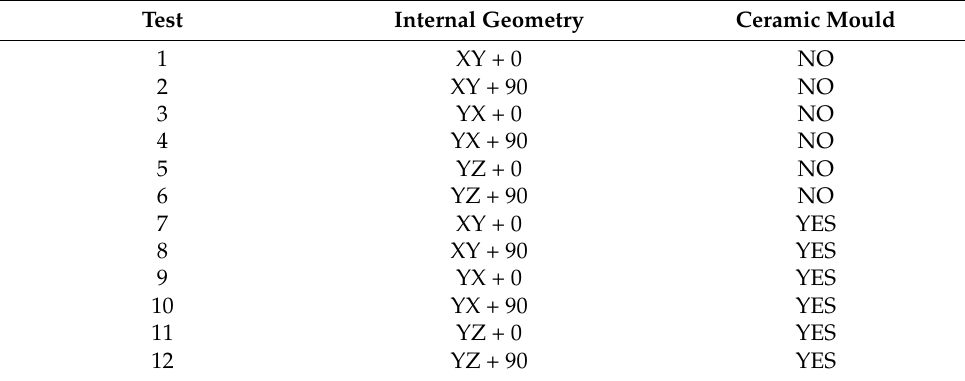
Table 3. Experimental parameters.